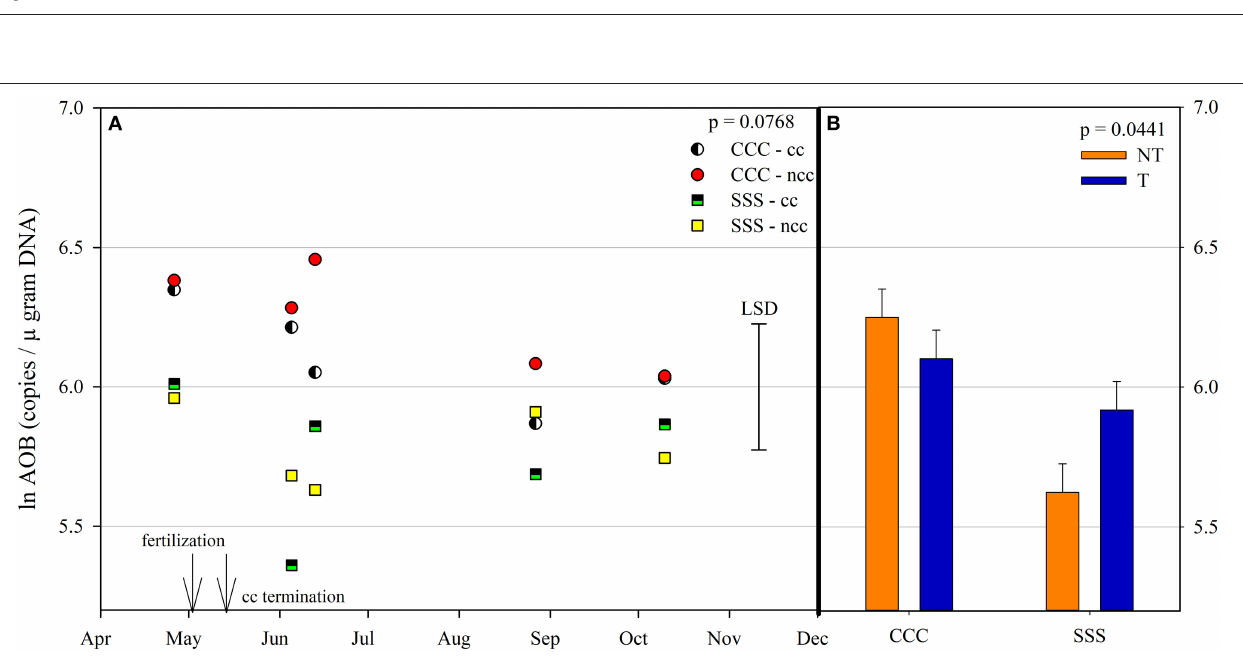
Frontiers in Agronomy |